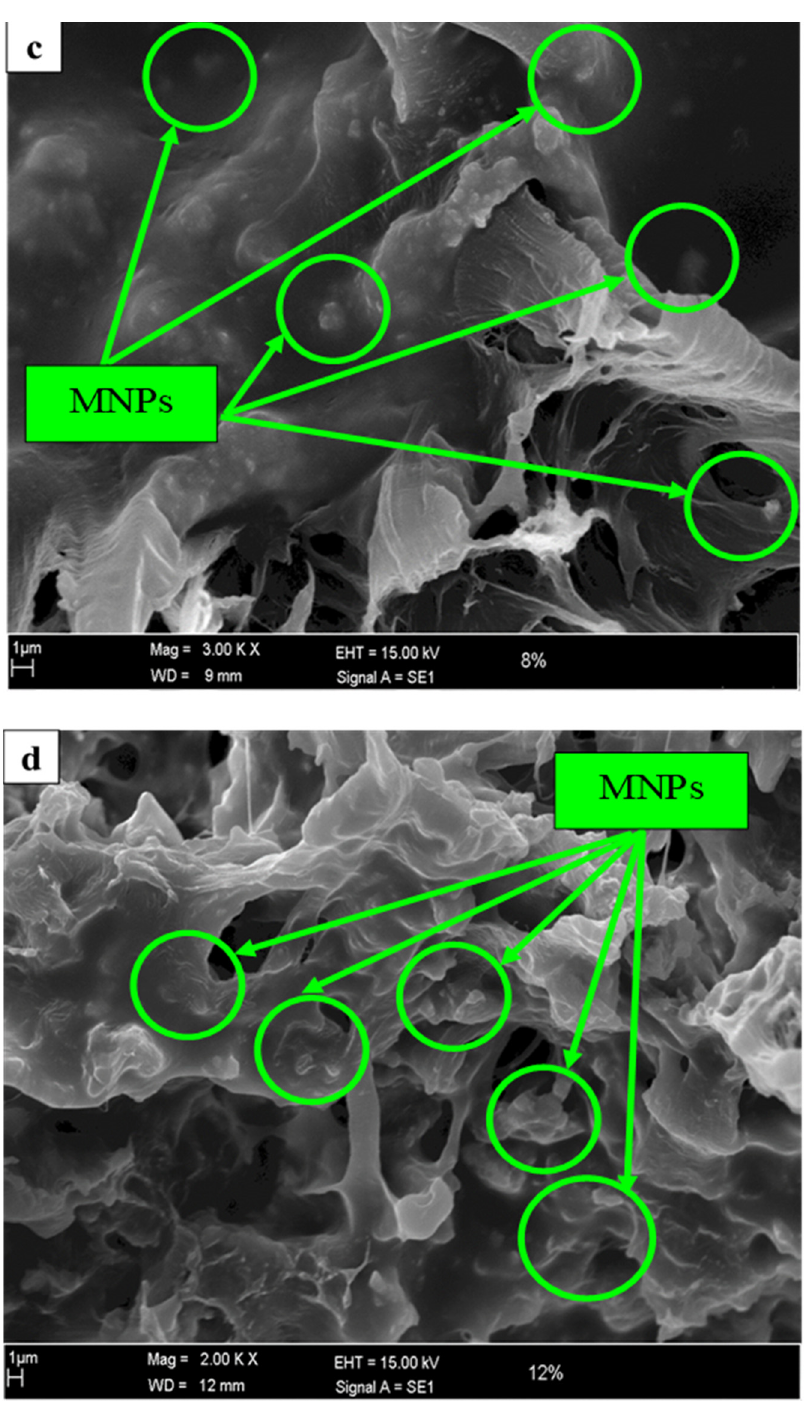
Figure 2. SEM micrographs of prepared nanocomposites ( a ) without magnetic filler content, and with ( b ) 4 wt%, ( c ) 8 wt%, and ( d ) 12 wt% of magnetic filler content.